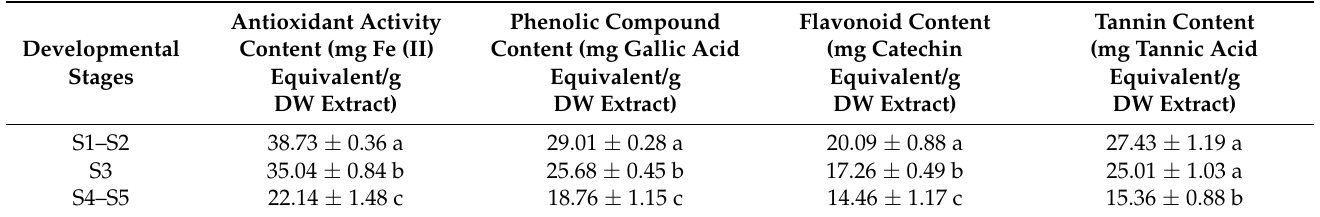
Table 4. Phytochemical compositions and antioxidant activity at different stages of Canephora coffee